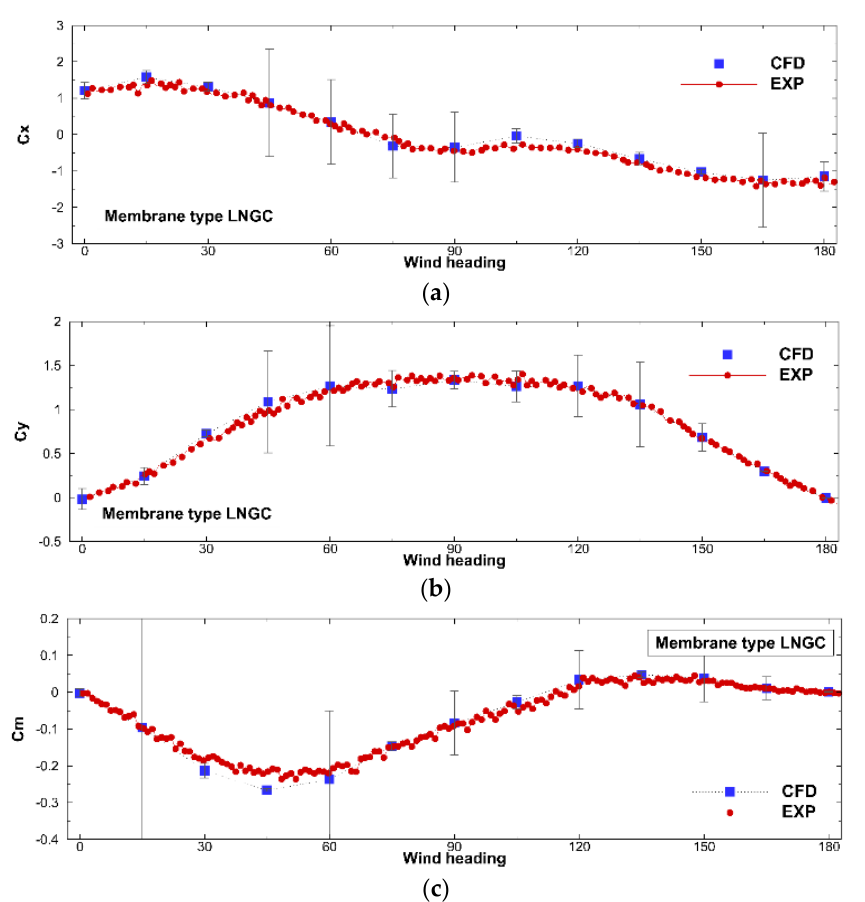
Figure 12. Comparison of aerodynamic coefficients for the membrane-type LNGC. (a) 𝐶 𝑥 ; ( b ) 𝐶 𝑦 ;